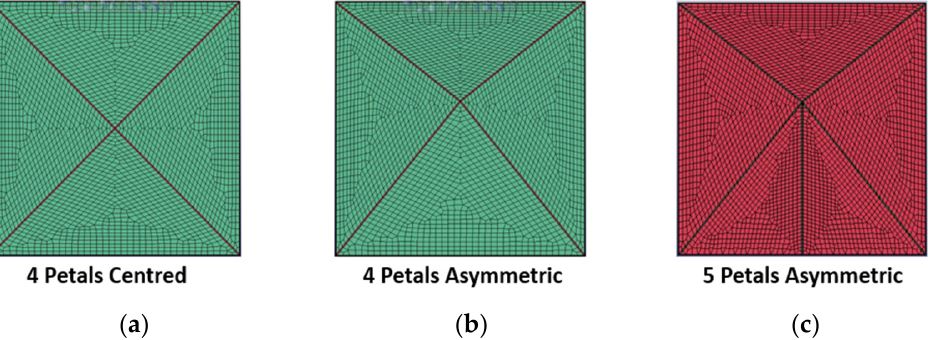
Figure 8. Planar tailgate configuration: ( a ) 4 petals centred, ( b ) 4 petals asymetric, ( c ) 5 petals asymmetric.